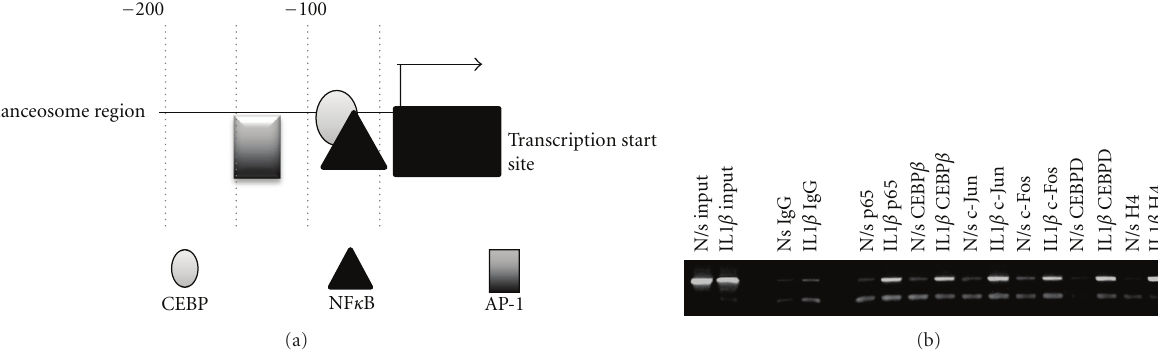
Figure 1: (a) Schematic of the IL8 promoter enhanceosome region. (b) ChIP analysis demonstrates the in vivo binding of NF κ Bp65, CEBP β and d, c-Jun, c-Fos, and H4 to the transcriptional enhanceosome of the IL8 promoter. ChIP assay using antibodies against NF κ Bp65 and CEBP β and -d, c-Jun, and c-Fos was performed in nonstimulated (N/s) and IL1B stimulated conditions. The immunoprecipitates were subjected to PCR analysis using primer pairs spanning the IL8 promoter transcriptional enhanceosome. The first two lanes are “input” lanes where no immunoprecipitation was performed prior to PCR. The second two lanes contained IgG antibody for immunoprecipitation (negative controls).